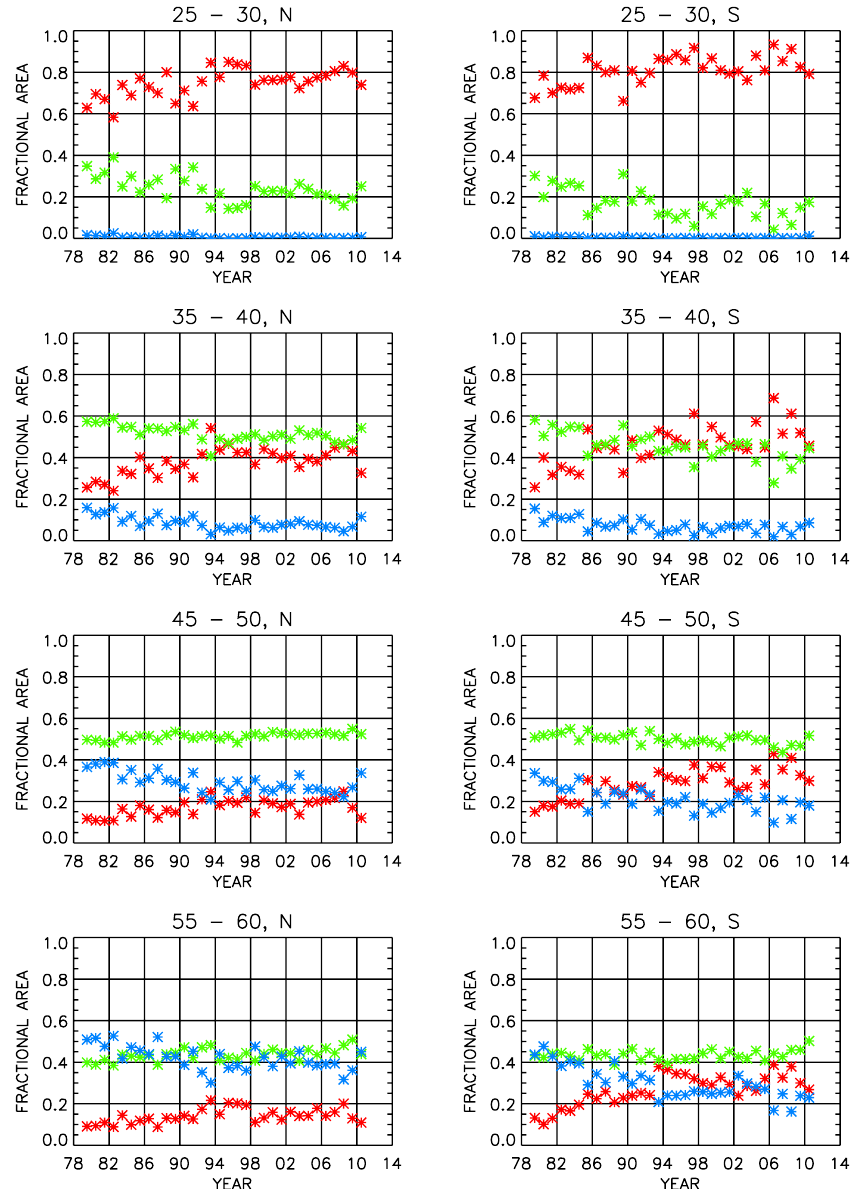
Fig. 8. The annual average fractional areas for the Tropical, mid-latitude, and Polar regimes versus time for both hemispheres, for 4 latitude bands. The Tropical regime is shown as the red stars; the midlatitude regime as the green stars, and the Polar regime as the blue